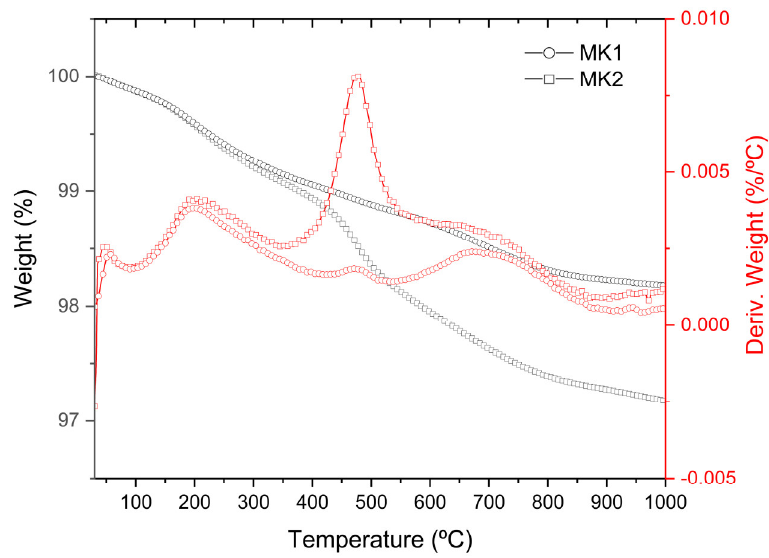
Figure 2. TG/DTG curves for samples MK1 and MK2.